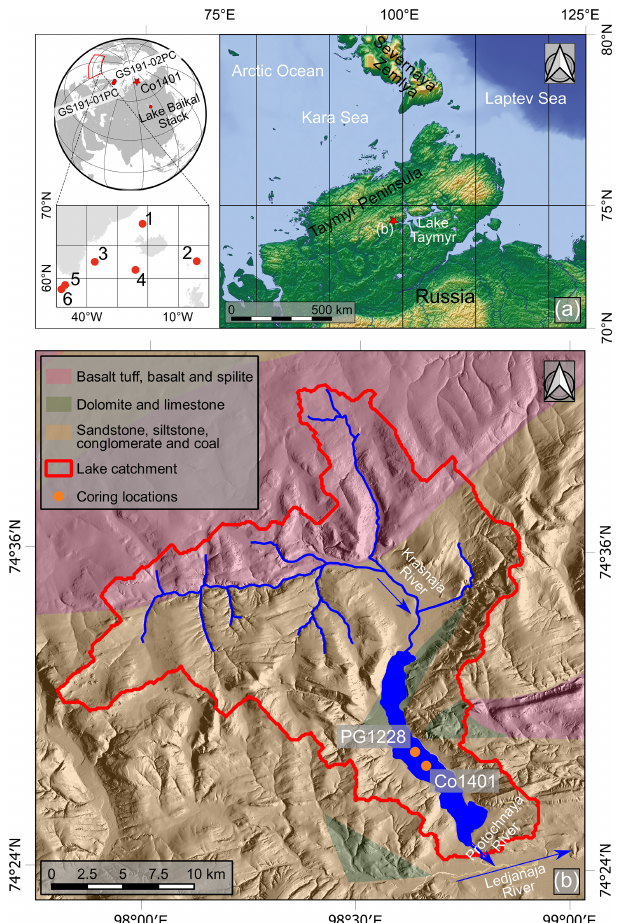
Figure 1. Locations of core Co1401 (red star) and of further records discussed in this study (red dots). (a) The map shows the location of Lake Levinson-Lessing (red star) to the west of Lake Taymyr on the northern Taymyr Peninsula in the Russian Arctic. On the left: records discussed in the text (red dots) named or abbreviated as follows: 1 – PS2644-5; 2 – MD95-2009; 3 – SU90-24; 4 – ODP site 984; 5 – P012; 6 – P013. Maps created using GMT 6 (Wessel et al., 2019). (b) Map of the coring sites Co1401 and PG1228 (orange dots) including the main geological units (Gromov et al., 2014) in the catchment area of Lake Levinson-Lessing. Topography is based on ArcticDEM (Porter et al.,